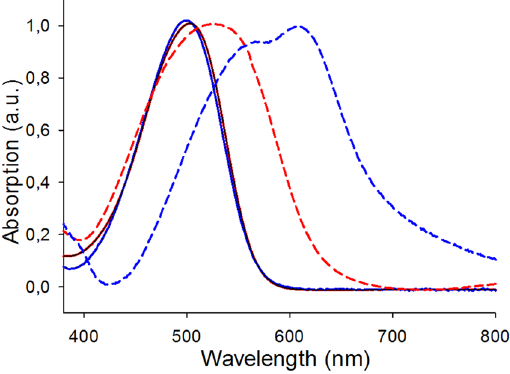
Figure 3. Normalized UV-vis absorption spectra of M3 (blue) and D (red). In solution (solid lines) and as thin film on glass (dashed